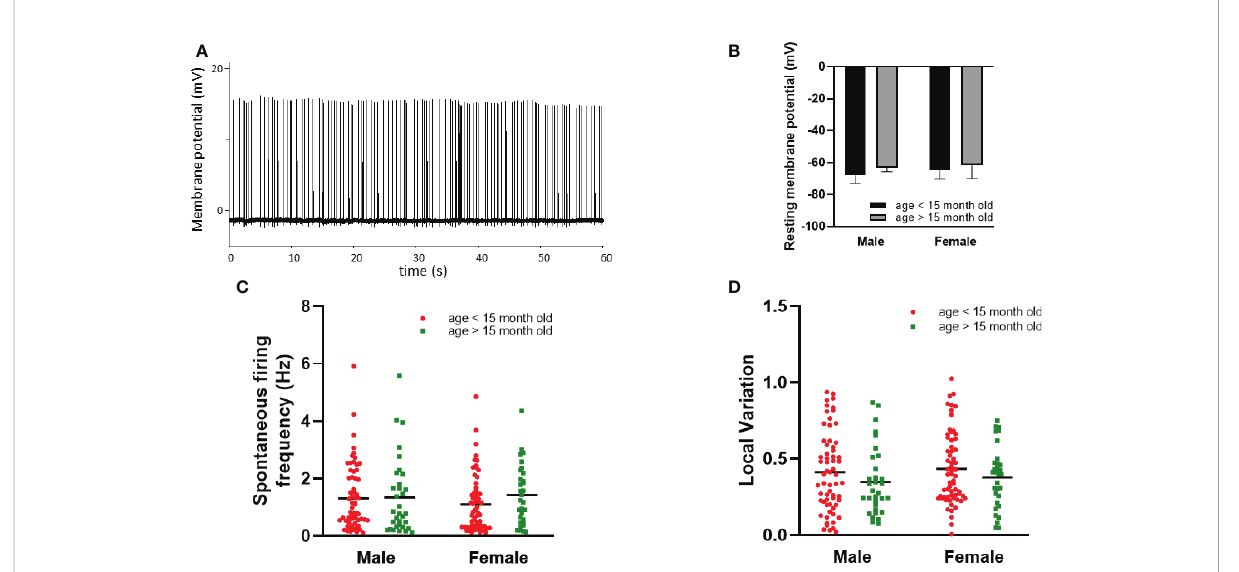
FIGURE 6 Effect of age and sex on intrinsic properties of striatal cholinergic interneurons. Representative, loose patch recording of spontaneous activity obtained from a striatal cholinergic neuron is depicted in Panel (A) . The resting membrane potential, the frequency, and the local variation of spontaneous fi ring activity in males and females is presented in Panels (B-D) , respectively. Data in one gender were further divided based on